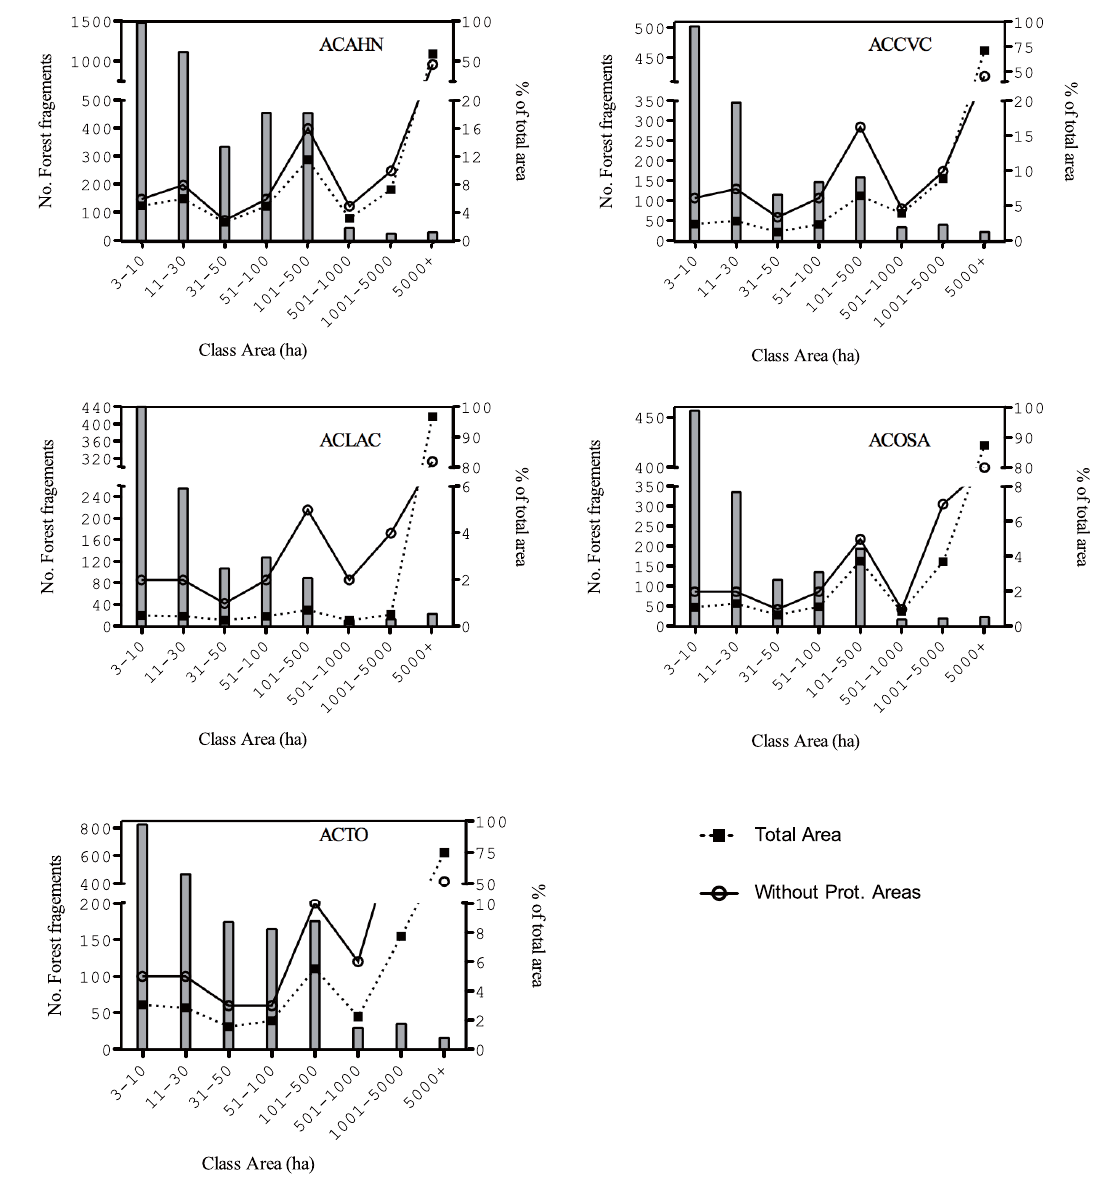
Figure 4. Number of forest fragments (left y axis) and percentage of the total % forest area (right y axis) with and without protected areas (e.g., National Parks) for five Conservation Areas in Costa Rica; the class area (ha) represents intervals for different forest fragment sizes encompassing small forest fragments to very large continuous forest areas (5000+